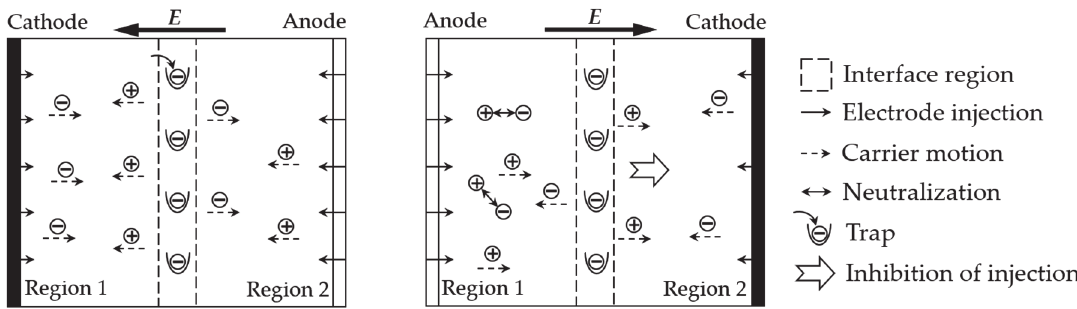
Figure 9. Schematic diagram of the e ff ect of interface region on carrier motion in a cycle of alternating current (AC) voltage.